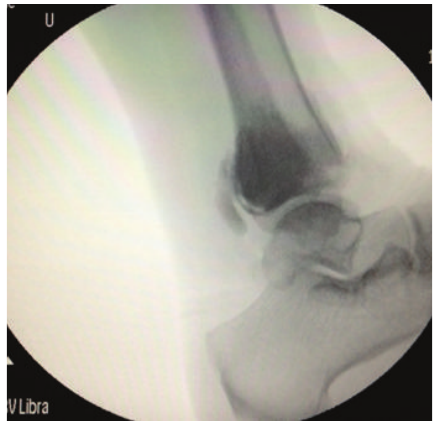
Figure 3: Postoperative